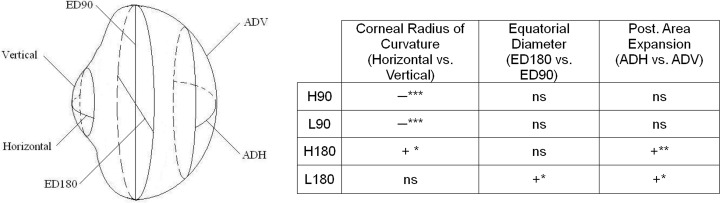
Effects of imposing WTR and ATR astigmatisms on eyeshape parameters.Comparisons of the effects of imposing WTR (H90 & L90) and ATR (H180 & L180) astigmatism on the horizontal and vertical meridians of corneal radius of curvature, equatorial diameter, and posterior ocular expansion. As illustrated in the schematic diagram, the comparisons were made for corneal curvatures of horizontal vs. vertical meridians; equatorial diameters of the horizontal (ED180) vs. vertical directions (ED90); and the difference in area up to 50° eccentricity of the horizontal (ADH) vs. vertical meridians (ADV). The table on the right summarizes the results of comparisons, the “+” and “−” signs indicate a significantly higher (horizontal>vertical) and lower (horizontal<vertical) values respectively, the “ns” represents no significant difference. The levels of significant difference, using paired t-test, are indicated by asterisk: * p≤0.05, **p≤0.01, *** p≤0.001.